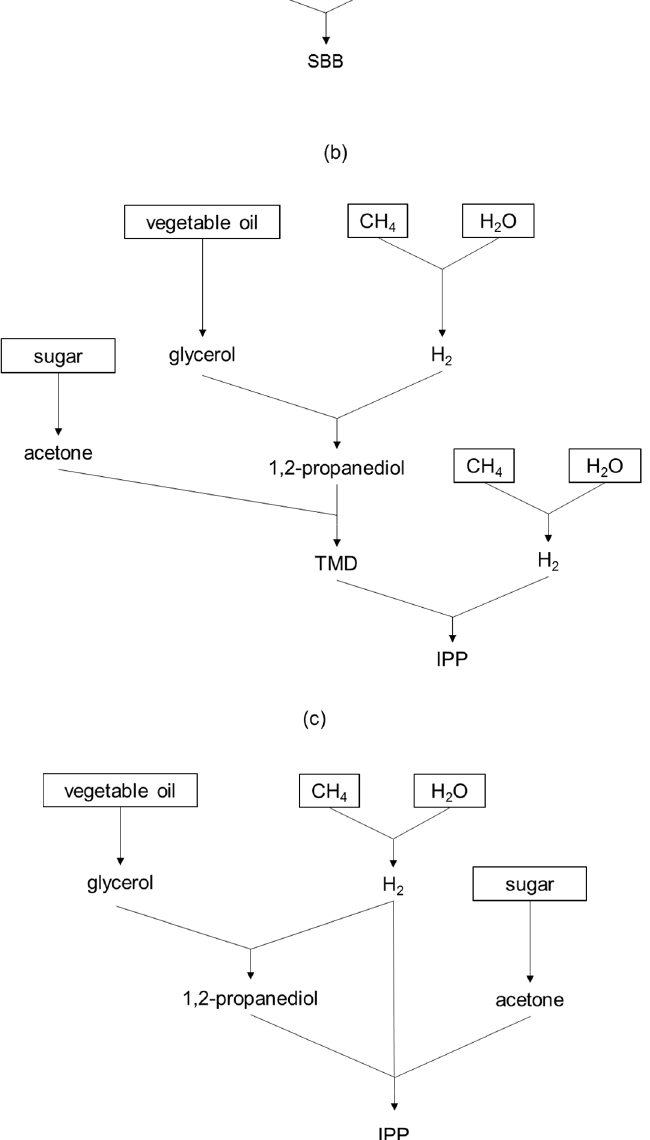
Figure 4. The synthesis trees for the renewable glycol derivatives: ( a ) ETMD and SBB, ( b ) IPP via the 1,2-PD ketalization and the TMD hydrogenolysis, ( c ) IPP via the reductive alkylation.